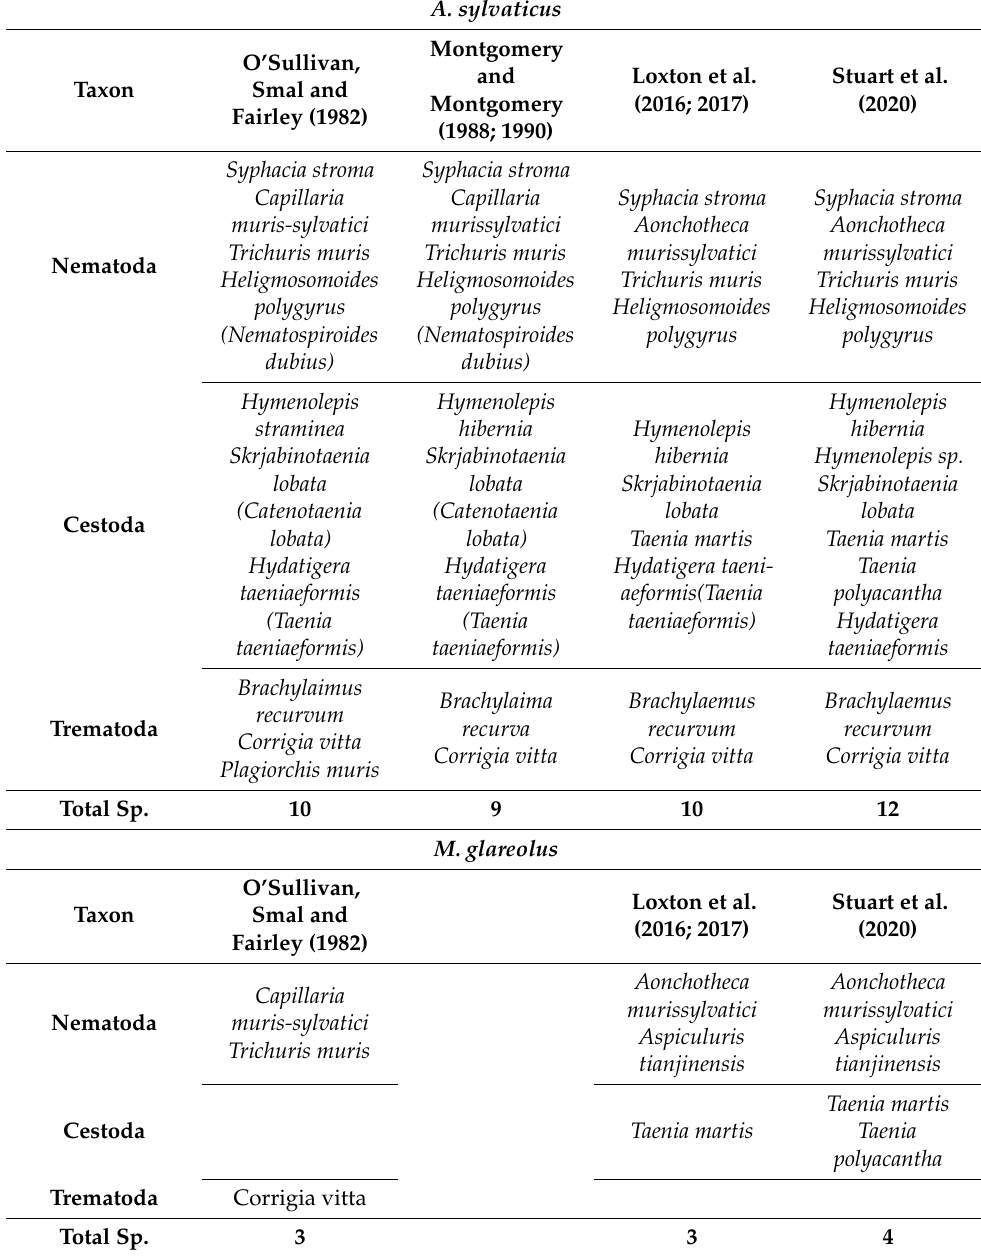
Table 1. Helminth species recorded in A. sylvaticus and M. glareolus from selected studies published between 1982–2020. Names in brackets are previous species